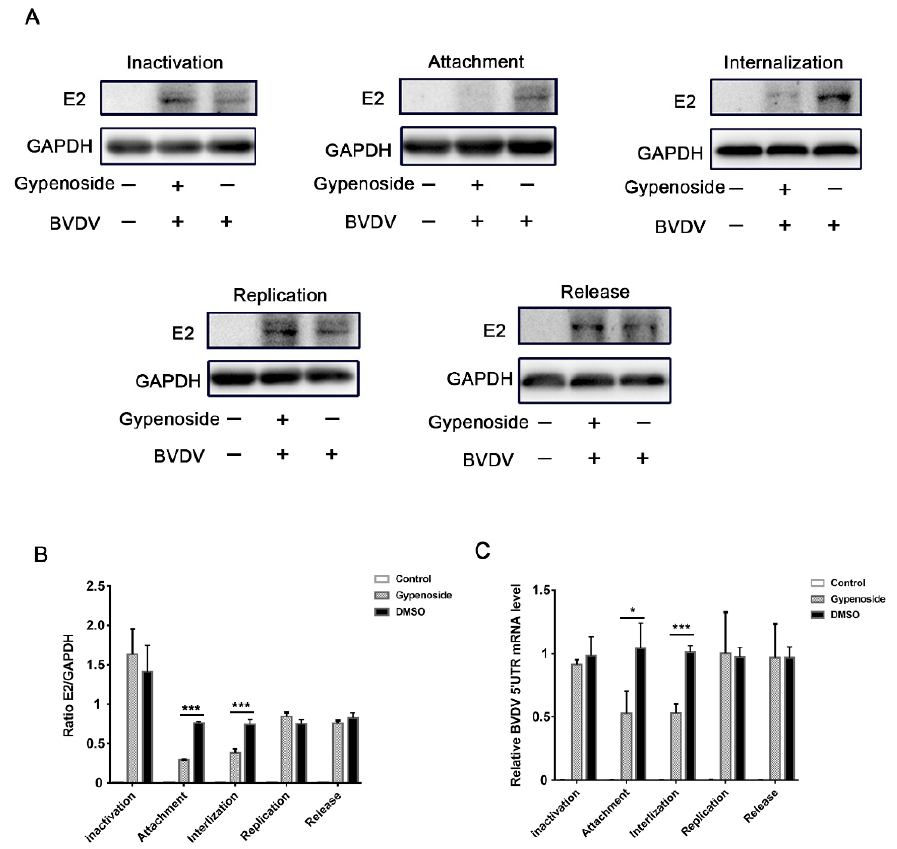
Figure 3. Gypenoside inhibits BVDV by affecting the viral attachment and internalization stage. ( A ) Western blotting analysis of the viral inactivation, viral binding, viral internalization, viral replication, and viral release assays in BVDV- infected MDBK cells treated with gypenoside. ( B ) The protein bands were quantified as the ratio of the intensity of the BVDV E2 protein band to that of the GAPDH band in Western blotting. ( C ) RT-qPCR analysis of the viral inactivation, viral binding, viral internalization, viral replication, and viral release assays in BVDV-infected MDBK cells treated with gypenoside. Data from three independent experiments and error bars are presented as the mean ± SEM. * p < 0.05, *** p <